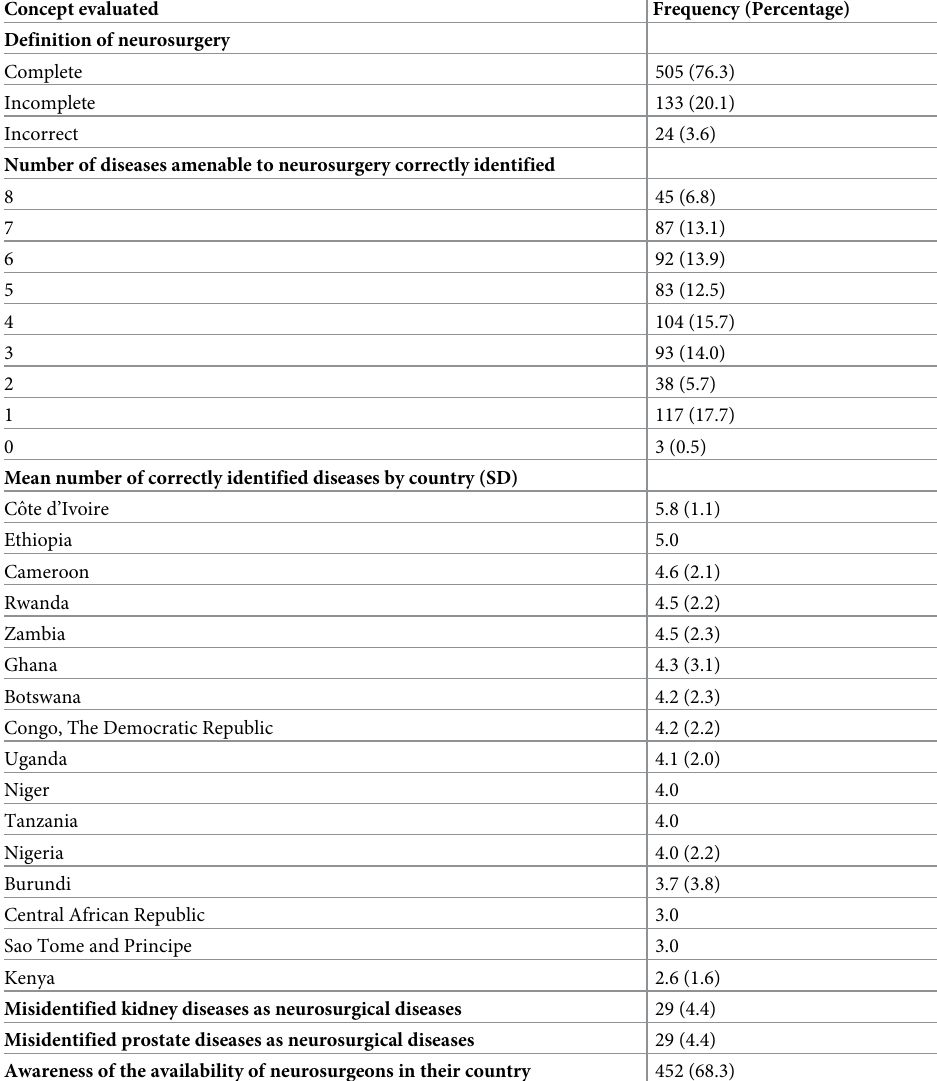
Table 2. Knowledge levels of survey